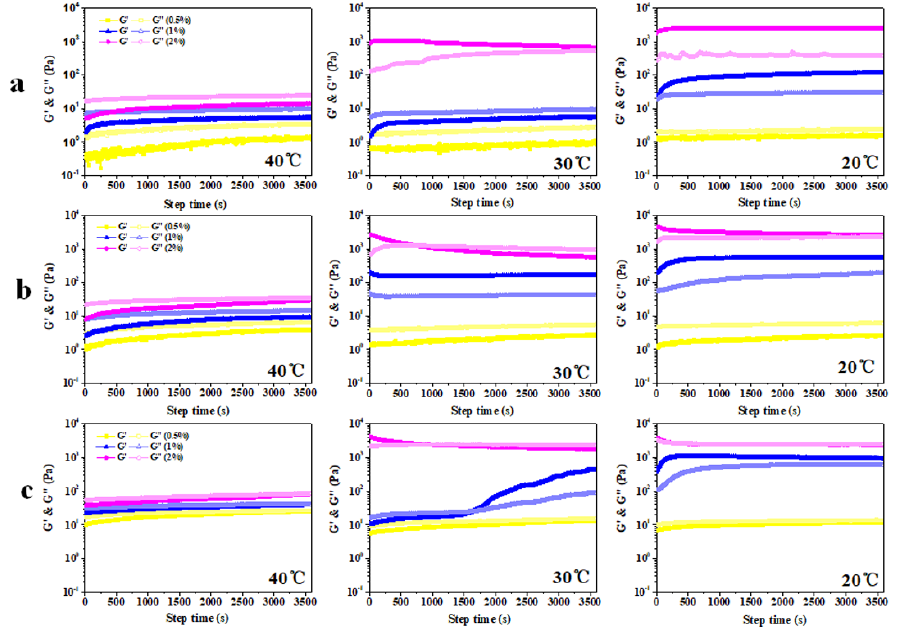
Figure 7. G′ and G″ of Pickering emulsion gel prepared by different concentrations of XG/Ly NPs (( a ) 0.5%, ( b ) 1%, and ( c ) 2%) at various concentrations of kC under different temperature conditions.